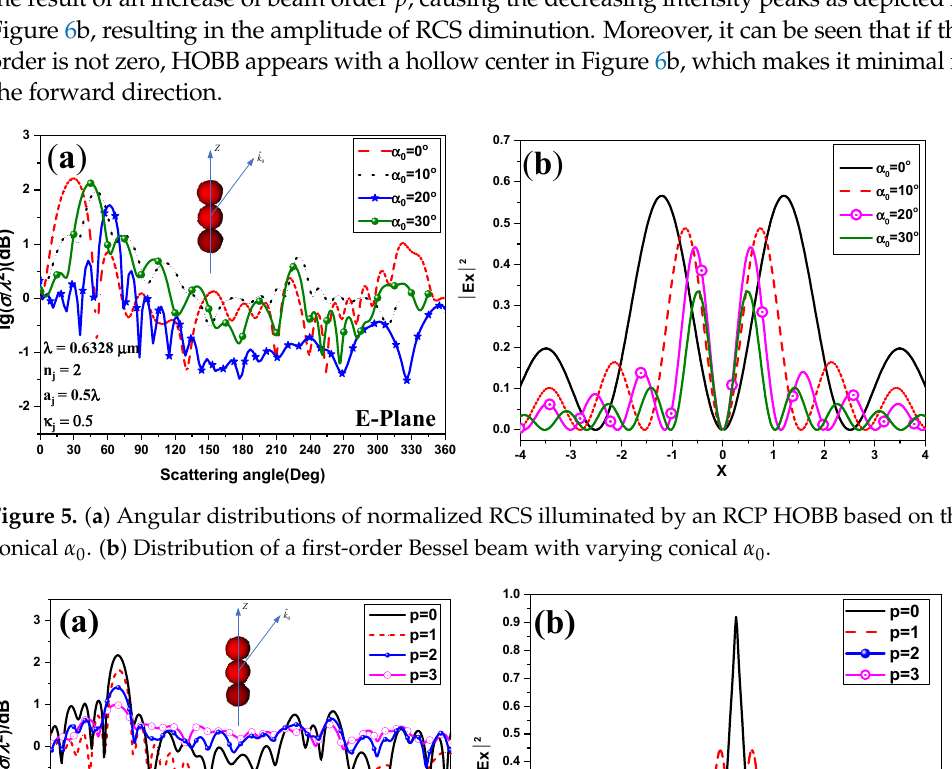
Figure 5. ( a ) Angular distributions of normalized RCS illuminated by an RCP HOBB based on the conical